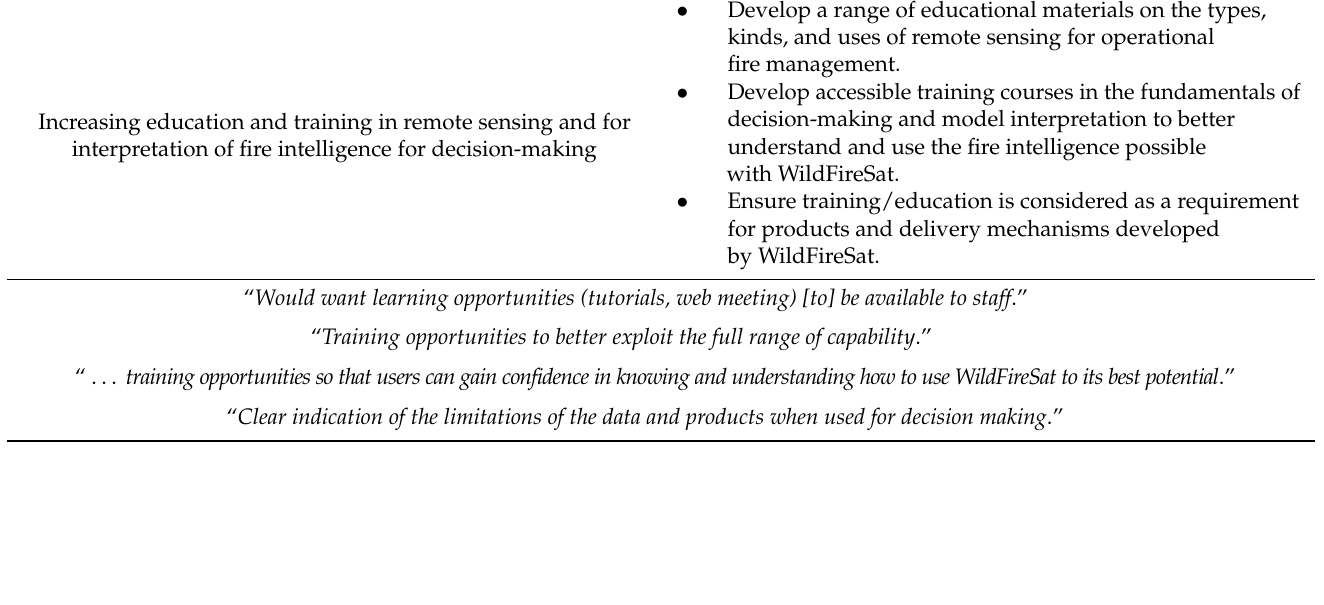
Table 3. Example of a strategy and corresponding activities which may increase readiness for WildFireSat.